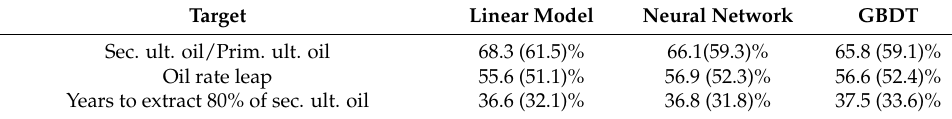
Figure 7. The histograms of the target metrics. Table 4. ML models sMAPE(%) on five-fold cross-validation. Metrics on training data in brackets.